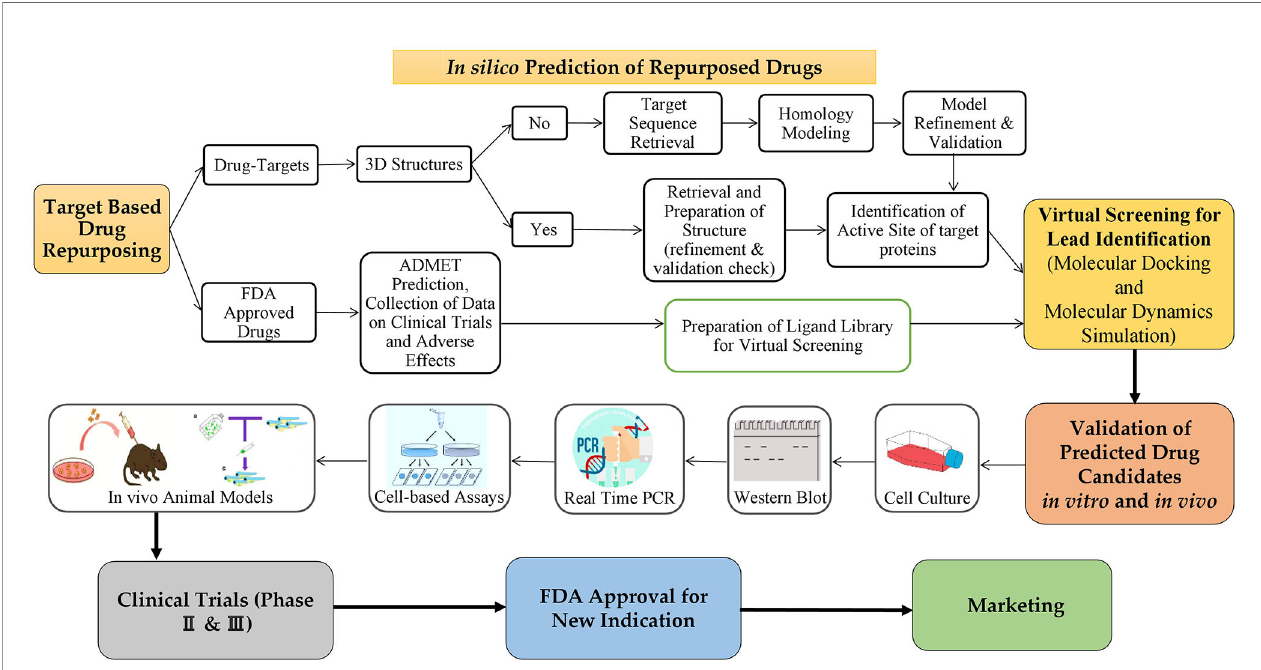
FIGURE 6 | The process of repurposing a drug for a new indication. Target based drug repurposing: Potent drug candidates targeting NSCLC can be predicted through in silico target-based drug repurposing approach based on several databases, tools and software. Then anticancer properties of predicted drugs can be validated in vitro via several cell-based assays for cancer followed by in vivo animal models. Further validation is done in clinical trials (phases 2 & 3 only) and then the drugs to be repurposed can be approved by FDA for clinical usage on the